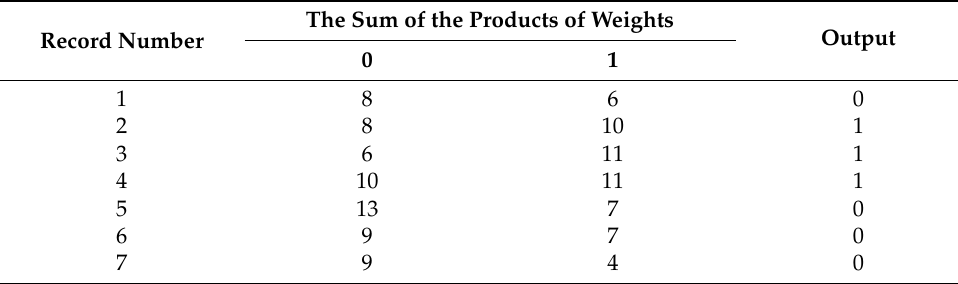
Table 12. Part of the results obtained without improvements.